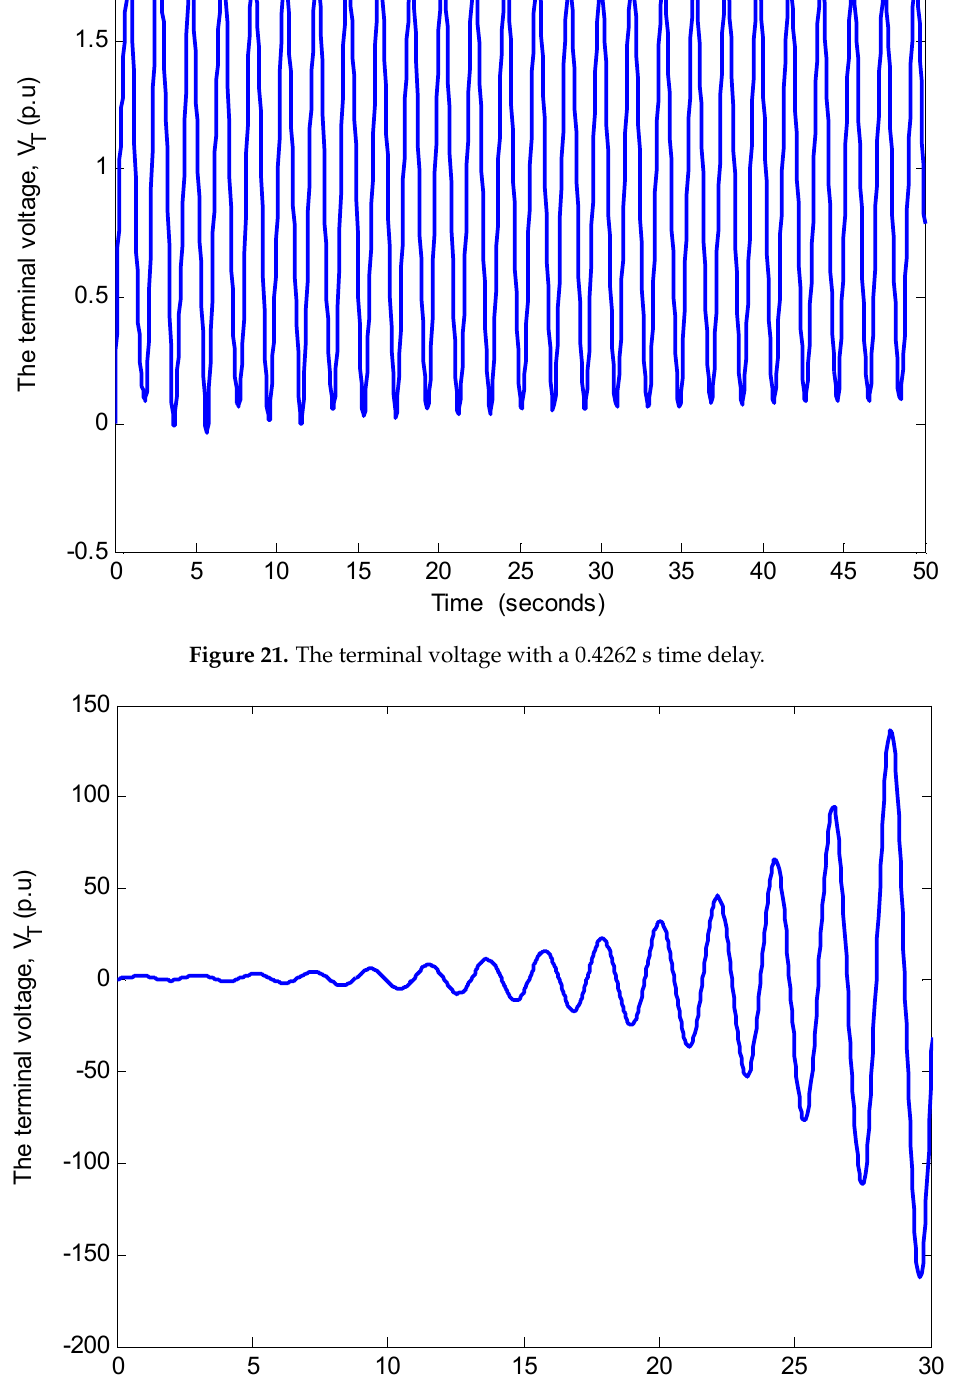
Figure 22. The terminal voltage with a 0.5 s time delay.